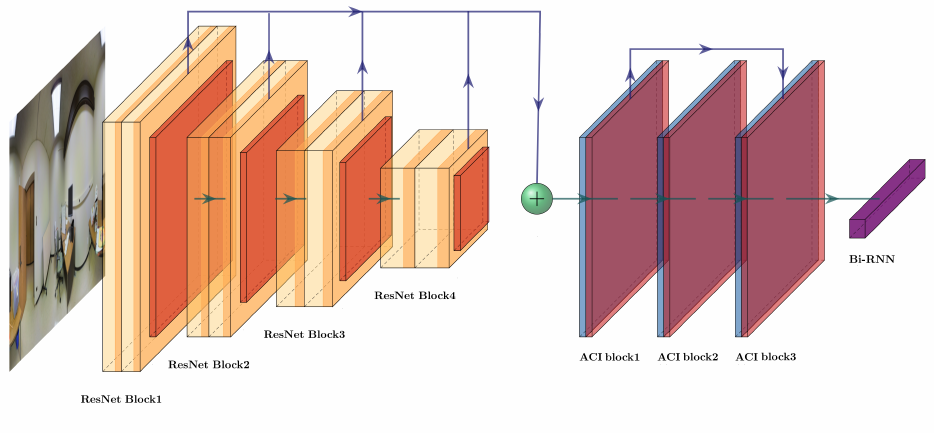
Figure 2. Architecture of the MreNet